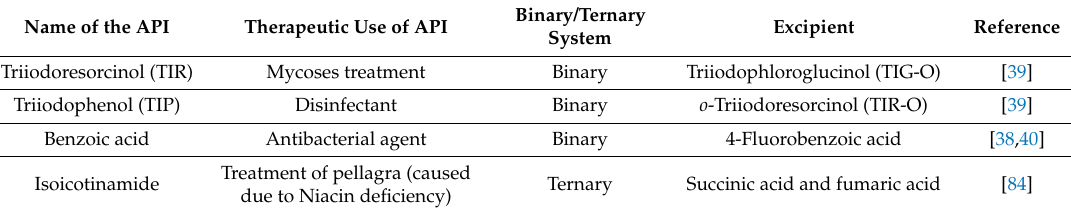
Table 4. Summary of a few reports available in the literature on drug solid